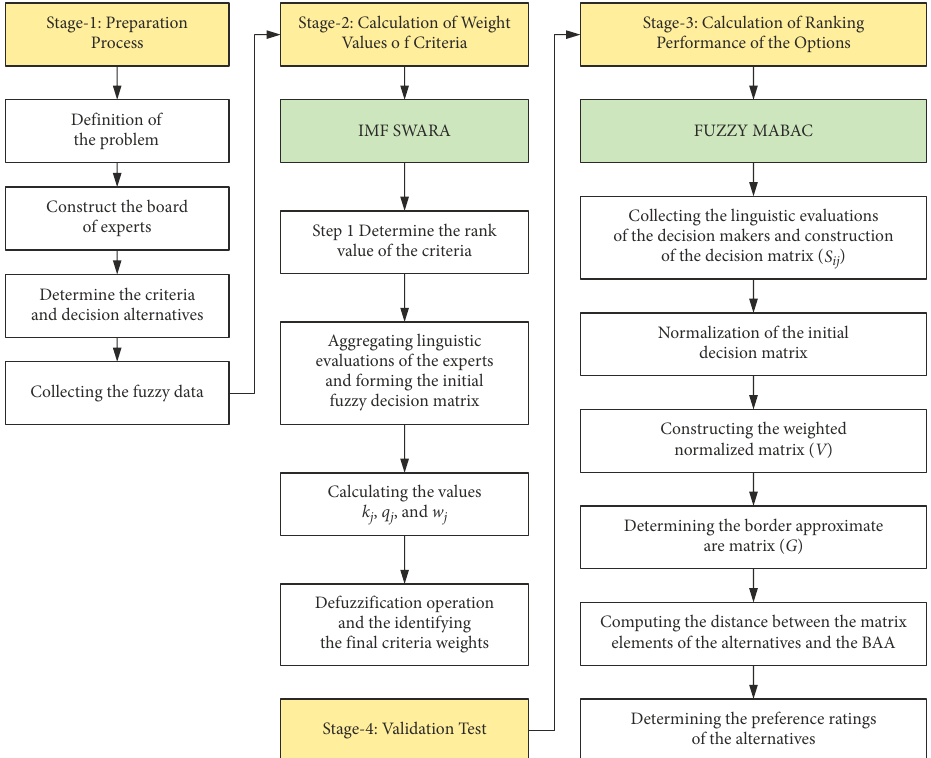
Figure 1. The flowchart of the proposed fuzzy hybrid